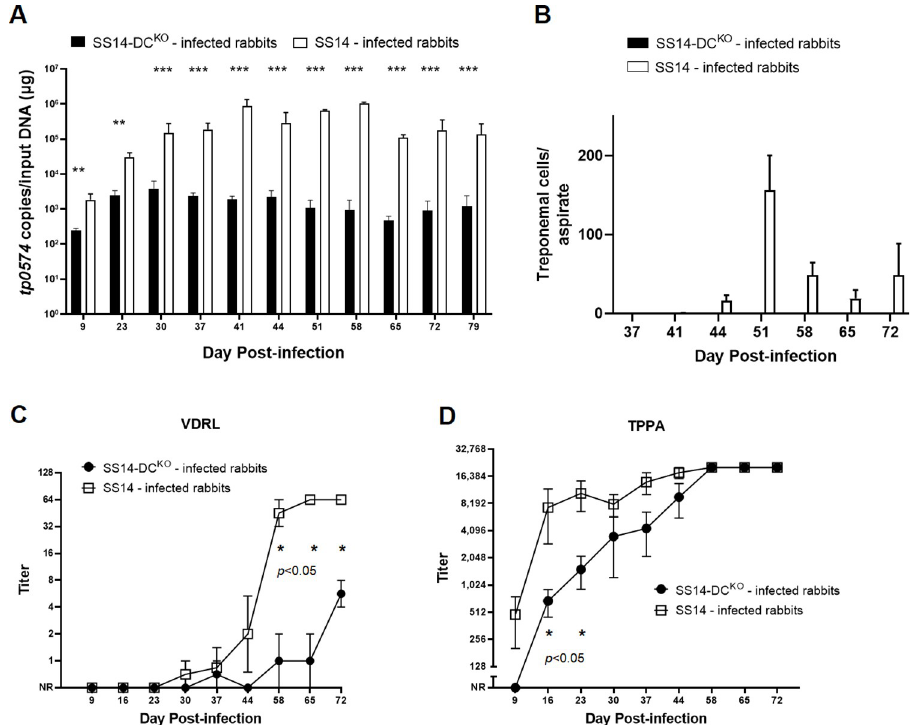
Fig 5. Treponemal burden and serologies of infected animals. (A) Treponemal burden in lesion biopsies collected from control and test animals assessed by qPCR targeting the tp0574 gene. The presence of T . pallidum DNA was confirmed in all samples, but treponemal burden in control samples was uniformly higher. Statistical analyses were performed using Student’s t -test, with significance set at p < 0.05 ( p < 0.01 is indicated with two asterisks, p < 0.001 is indicated with three asterisks). (B) Treponemal burden in lesion biopsies collected from control and test animals assessed by DFM in lesion needle aspirates. Treponemes could be detected only in samples from control rabbits. (C) Significant delay in development of VDRL antibody titers in sera collected from animals infected with the knockout strain compared to serum samples from control rabbits. Controls seroconverted earlier and achieved significantly higher titers compared to test animals. Uninfected rabbit sera (screened at animal arrival at the vivarium) pre- inoculation had no VDRL reactivity. (D) Initial delay in development of treponemal antibodies (assessed using the TPPA test) in test animals compared to control rabbits. Titer differences became not significant at day 30 post- inoculation. NR: Nonreactive. In both cases significance ( p < 0.05) was assessed by performing Student’s t -test. Uninfected rabbit sera (screened at animal arrival at the vivarium) pre-inoculation had no TPPA reactivity. suggesting that the treponemal burden in samples from test animals was always below the limit of detection of this assay unless rabbits were infected with the WT strain. VDRL tests performed on serum samples collected over time showed that the WT-infected animals seroconverted earlier and reached higher titers in a shorter time compared to the SS14-DC KO rabbits (Fig 5C). In rabbits infected with the mutant strain, only one rabbit had seroconverted by day 37 post-inoculation (1:2 titer). This titer, however, could not be repro- duced at day 44 post-infection (Fig 5C). VDRL titers between the two rabbit groups remained significantly different from day 58 to the end of the experiment. TPPA titers were significantly different between control and test rabbits only up to day 23 post-infection. Together, these data support impairment of the SS14-DC KO strain’s ability to proliferate in dermal lesions, leading to an overall lower treponemal burden and to a delayed development of VDRL and TPPA antibodies.